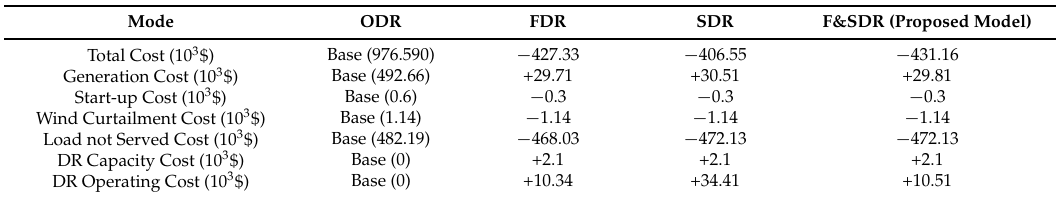
Table 7. DR scheduling modes impact on cost (wind power profile two and five scenarios): With transmission constraint.